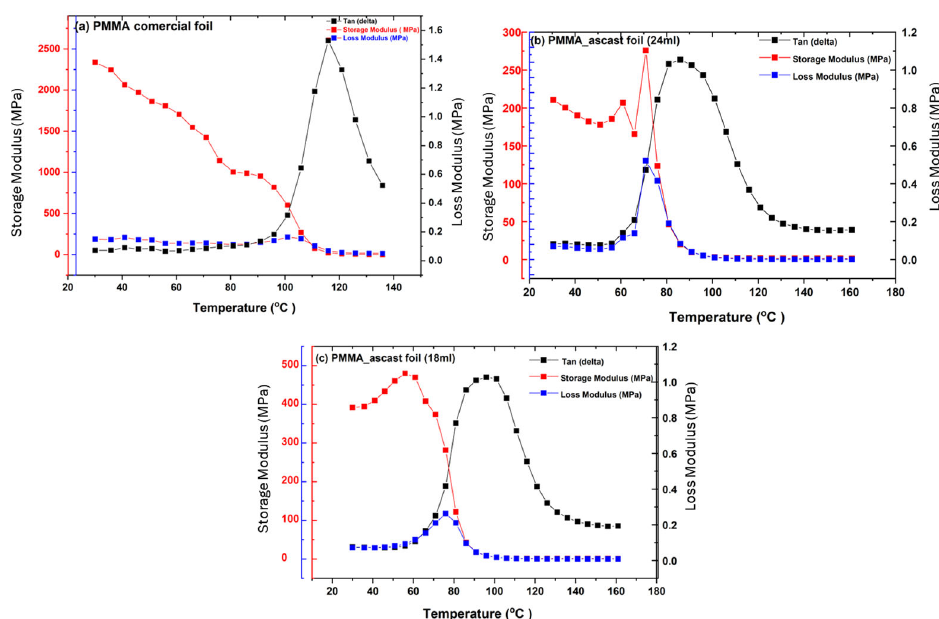
Figure 5. DMA behavior of ( a ) commercial foil and ( b , c ) as cast foils from 1/24 and 1/18 (S/L)